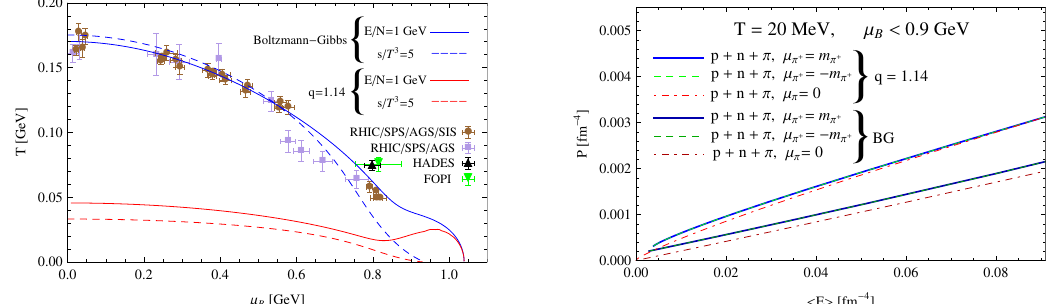
Figure 9. Left panel: Chemical freeze-out line T = T ( µ B ) obtained by assuming (cid:104) E (cid:105) / (cid:104) N (cid:105) = 1GeV (continuous lines) and s / T 3 = 5 (dashed lines). We plot the result by using Boltzmann–Gibbs statistics, and Tsallis statistics with q = 1.14. Experimental data are taken from: Relativistic Heavy Ion Collider (RHIC) /SPS /Alternating Gradient Synchrotron (AGS) /SIS , [98], RHIC/SPS/AGS [99],HADES [100], and FOPI [101]. Right panel: EoS of hadronic matter. Figure taken from ref.